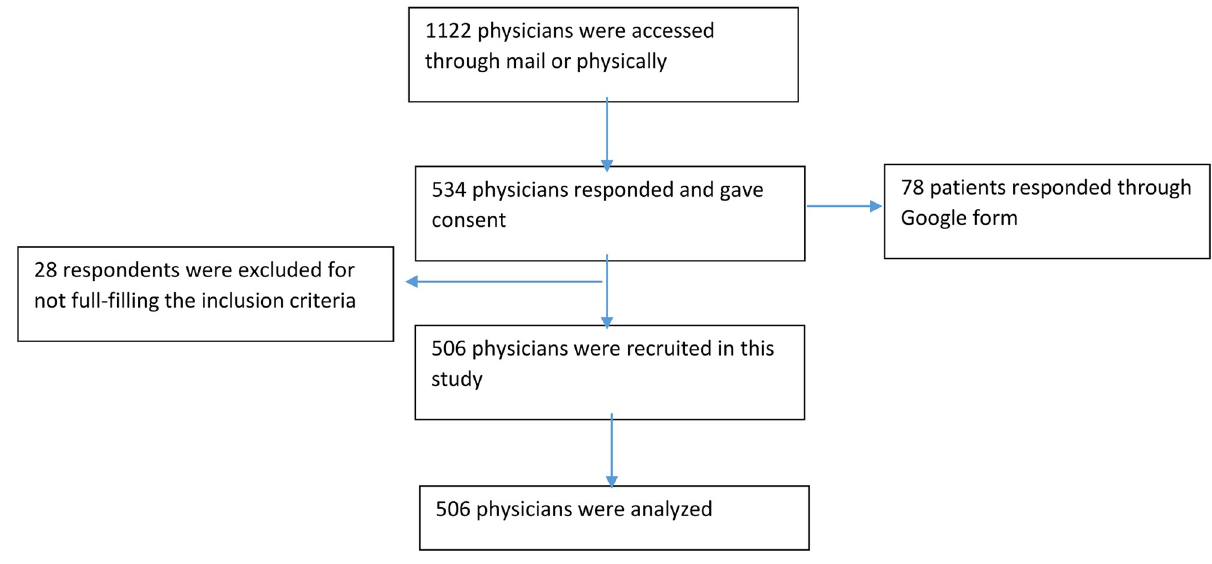
Fig 1. Patient selection for the cross-sectional